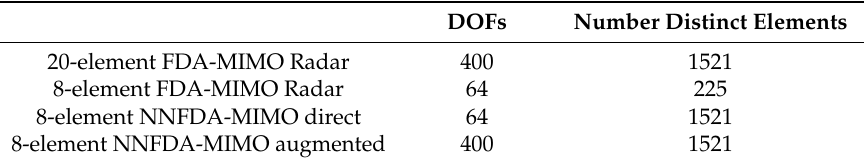
Table 2. The four DOFs and numbers of distinct